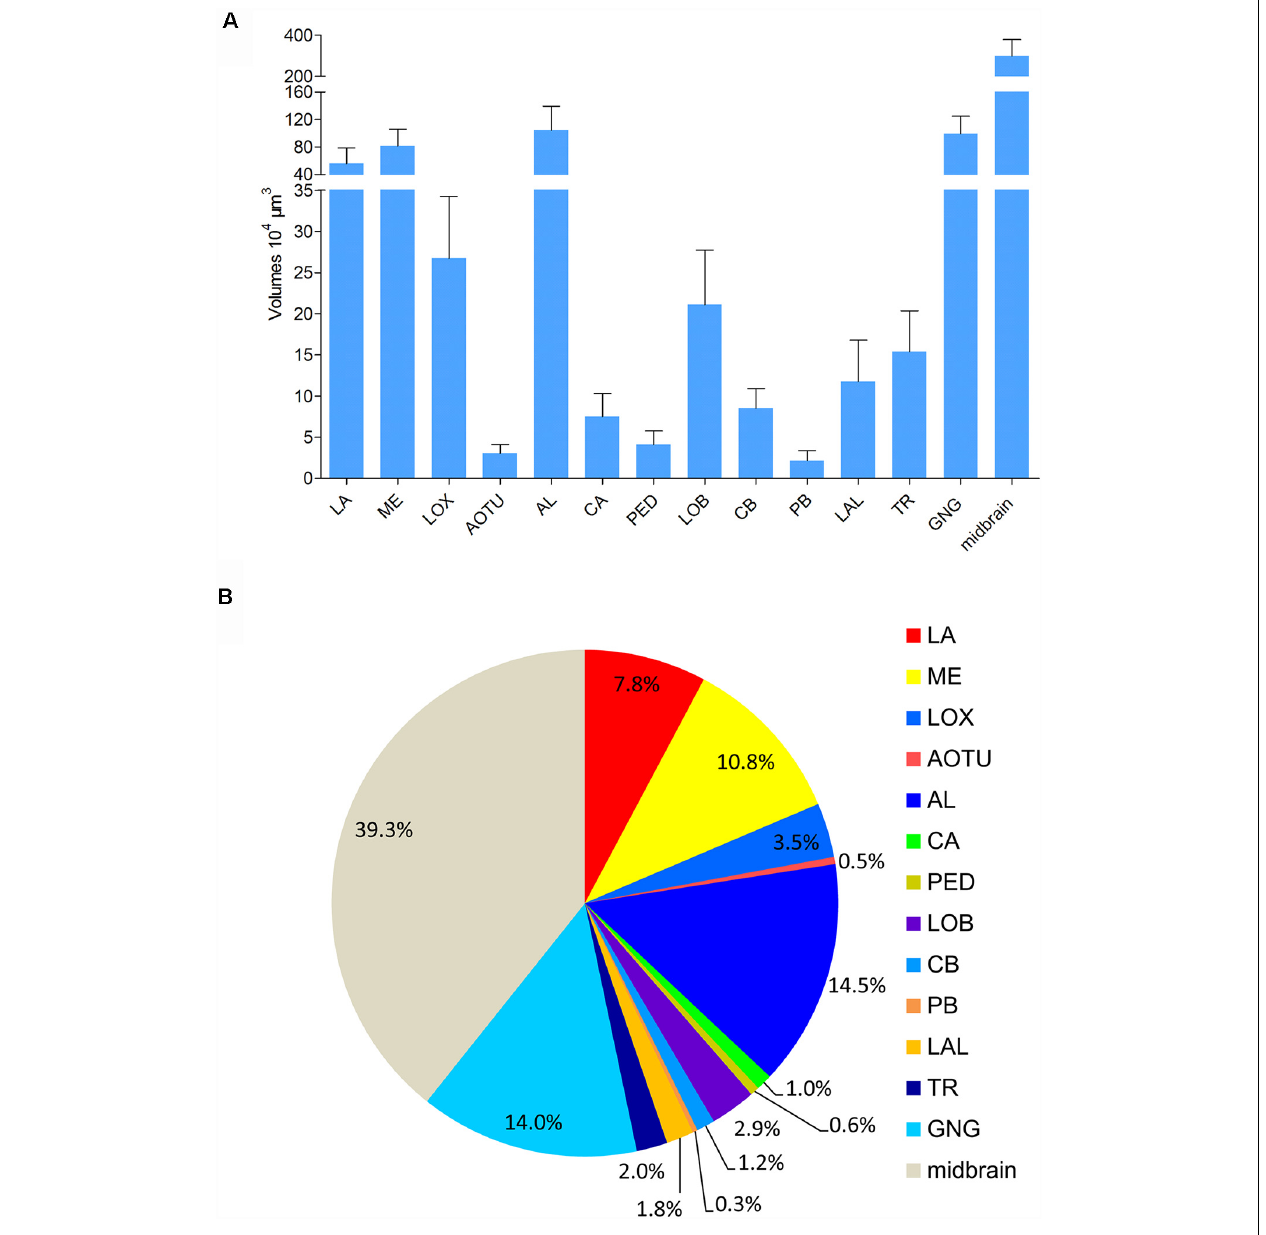
FIGURE 6 | Absolute volumes and relative sizes of prominent neuropils in the brain of Apolygus lucorum . (A) Absolute volumes. (B) Relative size (i.e., size relative to the volume of the whole brain). AL, antennal lobe; AOTU, anterior optic tubercle; CA, calyx; CB, central body; GNG, gnathal ganglion; LA, lamina; LAL,